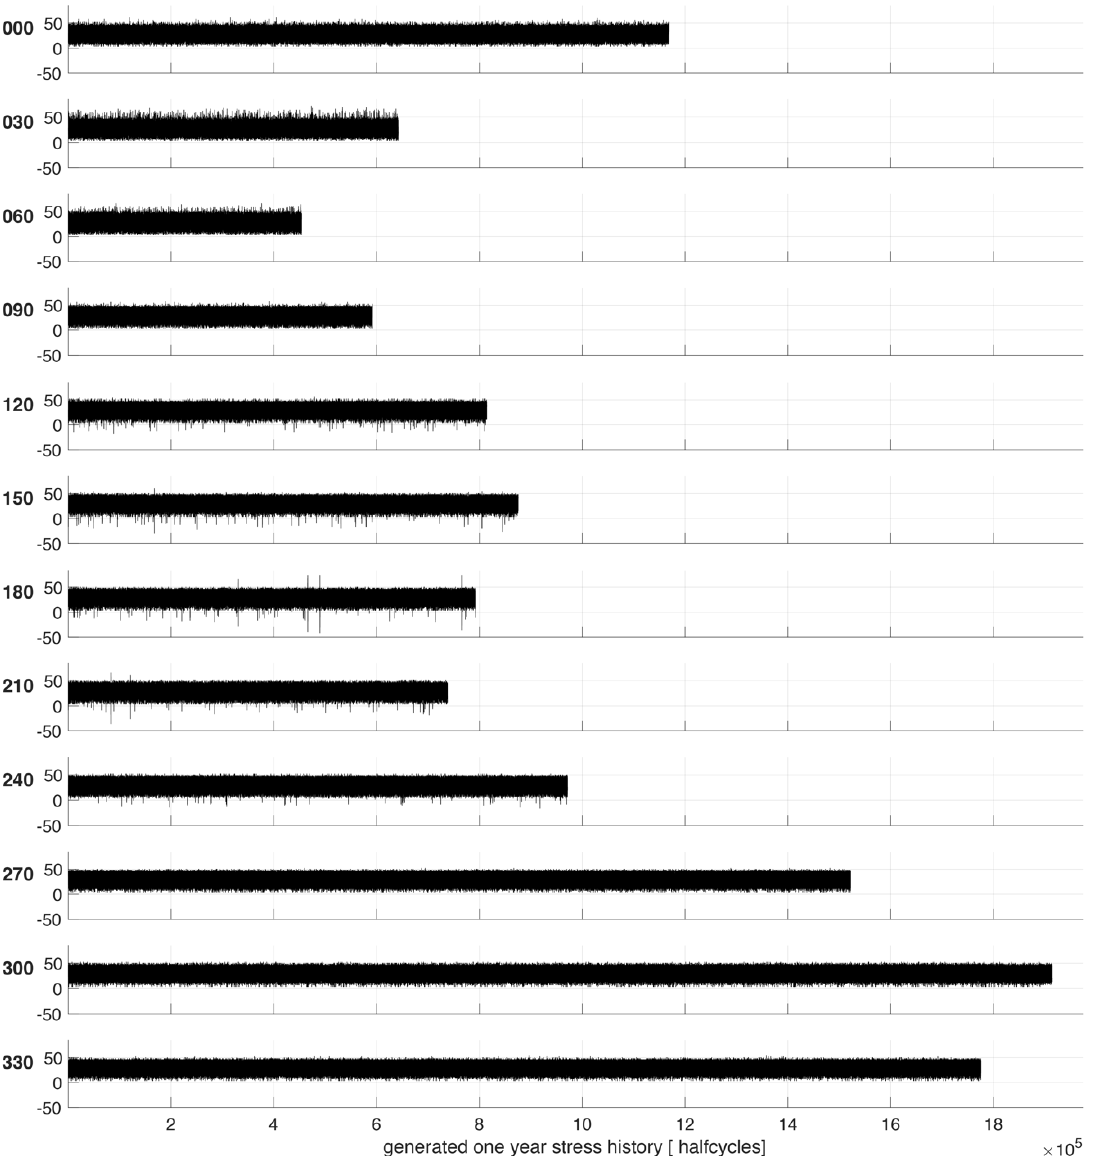
Figure 8. Random load cycles of one-year duration obtained from the Markov chain method for all 12 sectors with an applied omission level of 10%.